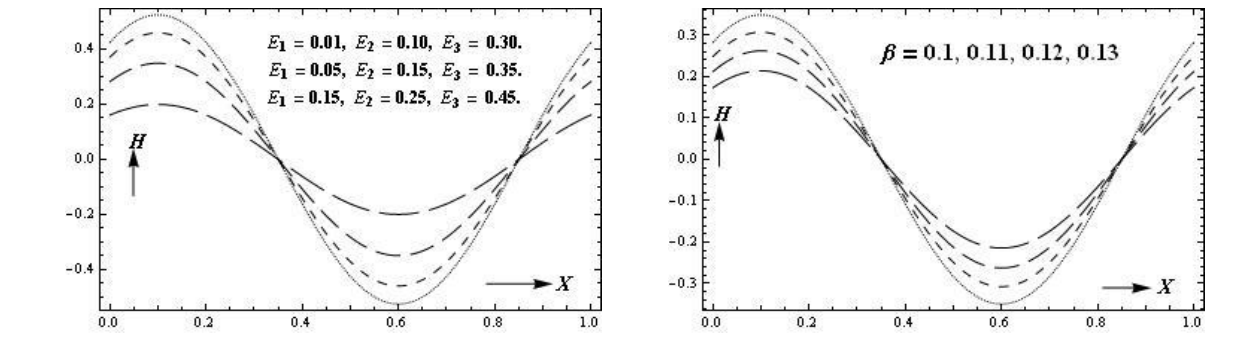
Figure 8 . Heat transfer coefficient for various values of elastic parameters.